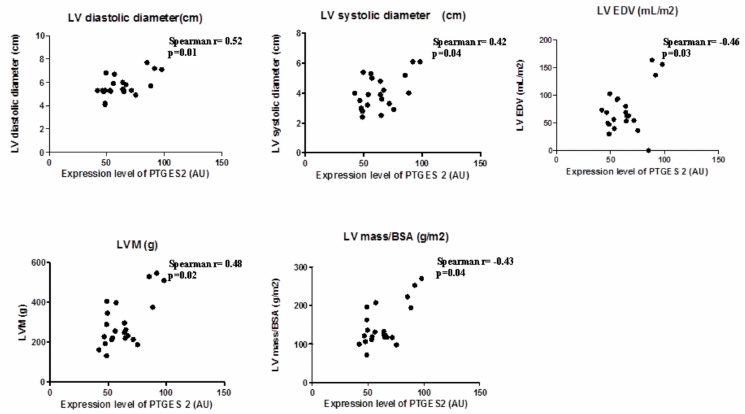
Figure 1. PTGES-2 molecular expression level in epicardial adipose tissue (EAT) of overweight CVD subjects.